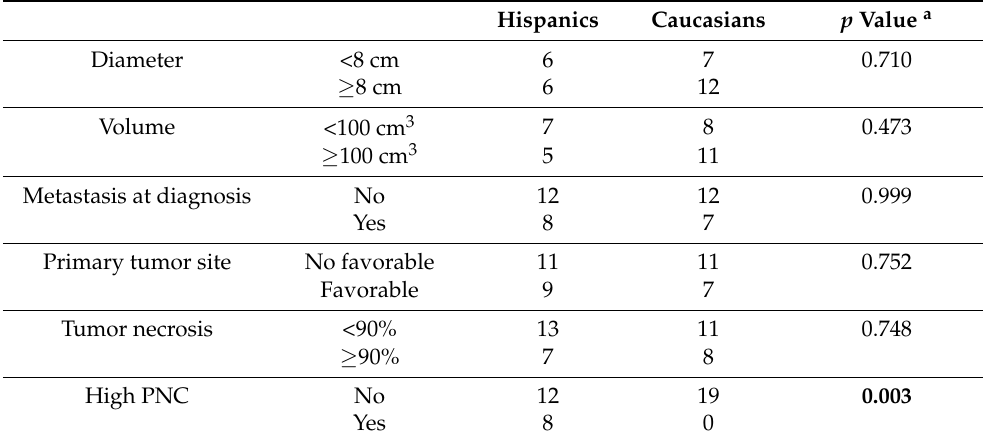
a bilateral exact significance by Fisher exact test. Bold font indicates significant p